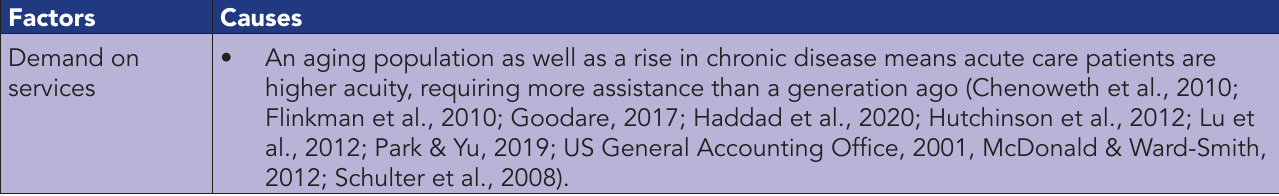
Table 8: Factors contributing to increases in nursing workforce shortages (pre-COVID-19)